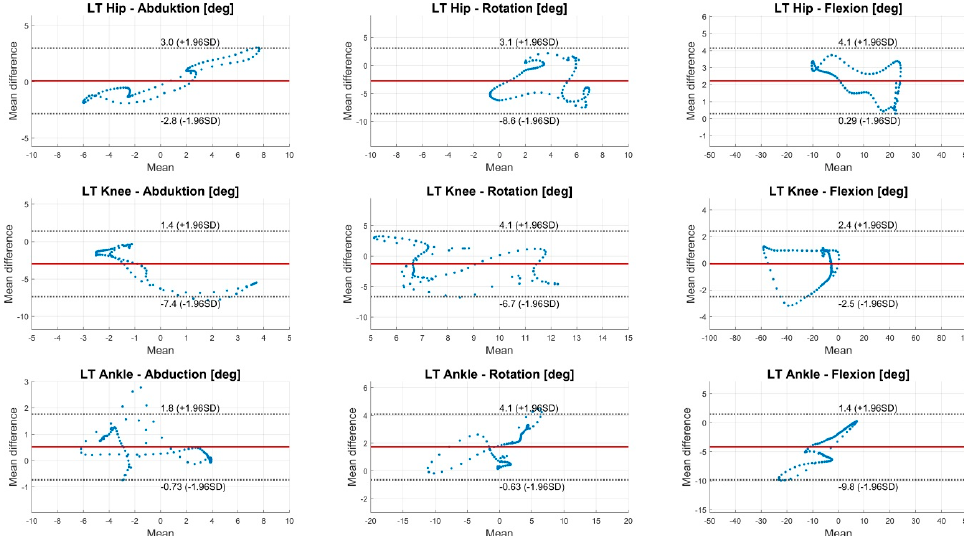
Figure A5. BA diagrams of 3D joint rotations of hip, knee, and ankle of the left side for condition 2. The solid line indicates the mean difference. The dashed lines indicate the LoA (95% CI of the mean difference). Sensors 2018 , 18 , x